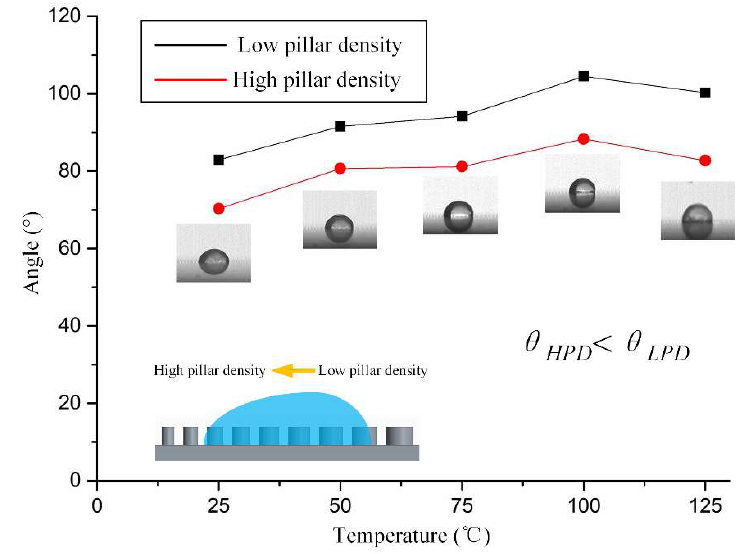
Figure 4. The static contact angle (CA) and asymmetric CA profiles along the wettability gradient’s orientation on the dry surface, under different temperatures conditions.